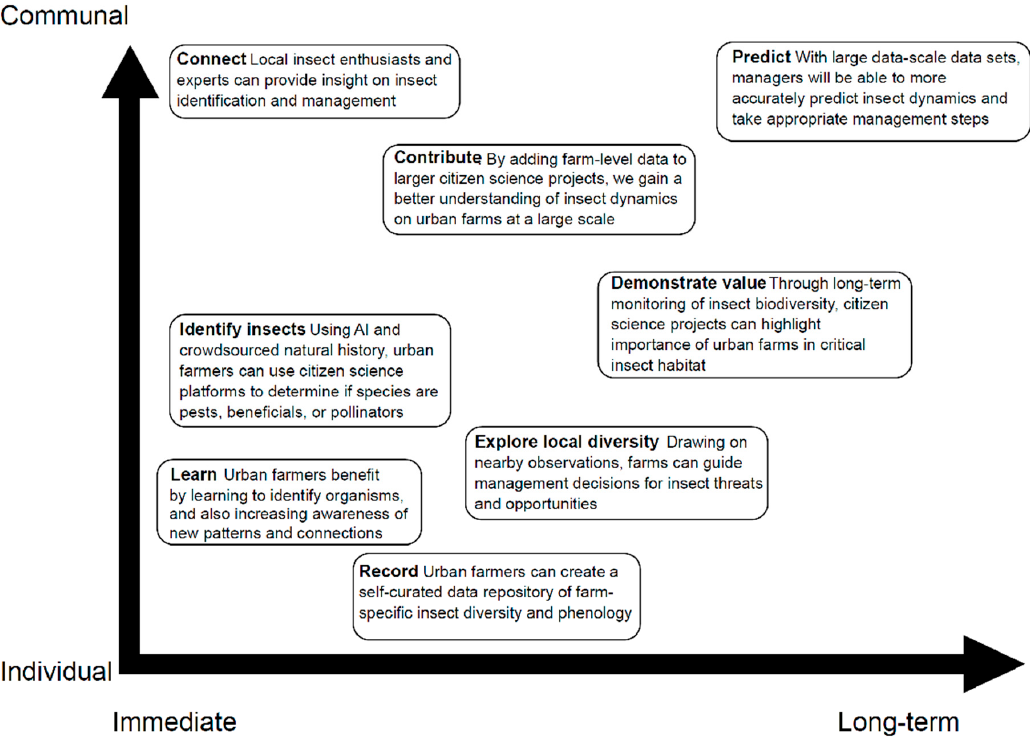
Figure 2. Value schematic of citizen science web-platforms for urban growers. Collaborative citizen science programs add value to urban farm mission and management by o ff ering connection to experts, customers, and community members. Here, we outlined the main ways that urban farms can use citizen science platforms, across two axes: immediate and long-term usage (horizontal) and individual and communal actions among users